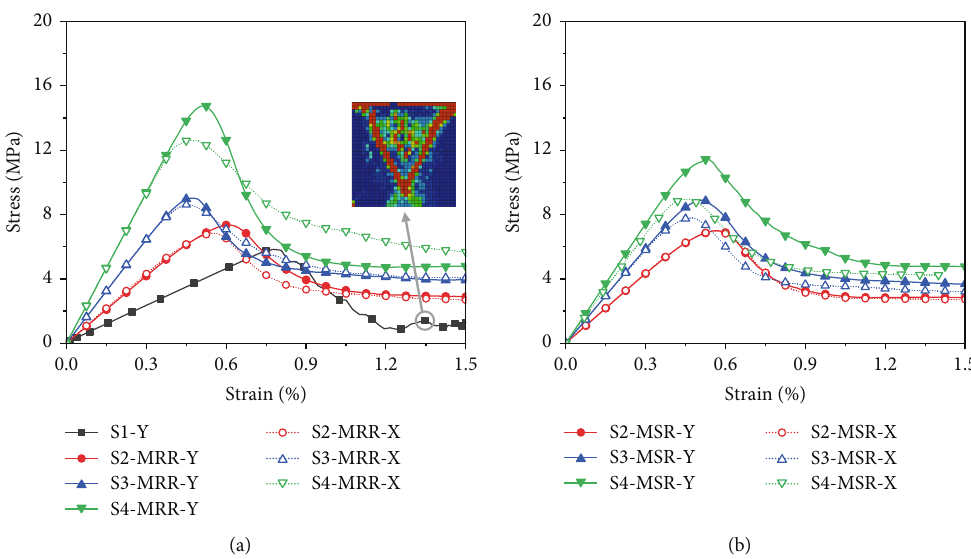
Figure 8: Stress – strain relationships of (a) the most representative regions (MRRs) and (b) the most special regions (MSRs) under two loading directions.